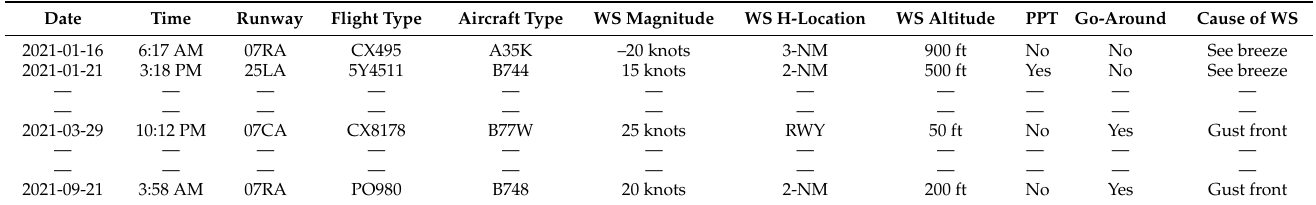
Table 3. Extracted environmental and situational factors from HKIA-based PIREPs.